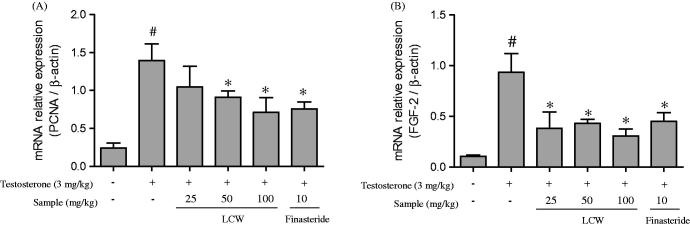
Effects of LCW on mRNA expression of PCNA and FGF-2 in TPH tissues. Transcript levels of (A) PCNA and (B) FGF-2 from prostate tissues of testosterone-treated rats with BPH that received oral administration of LCW as quantified by quantitative real-time PCR. Values are mean ± S.E.M. (n = 6). #p < 0.05, significantly different from the normal control group. *p < 0.05, significantly different from the TPH group.